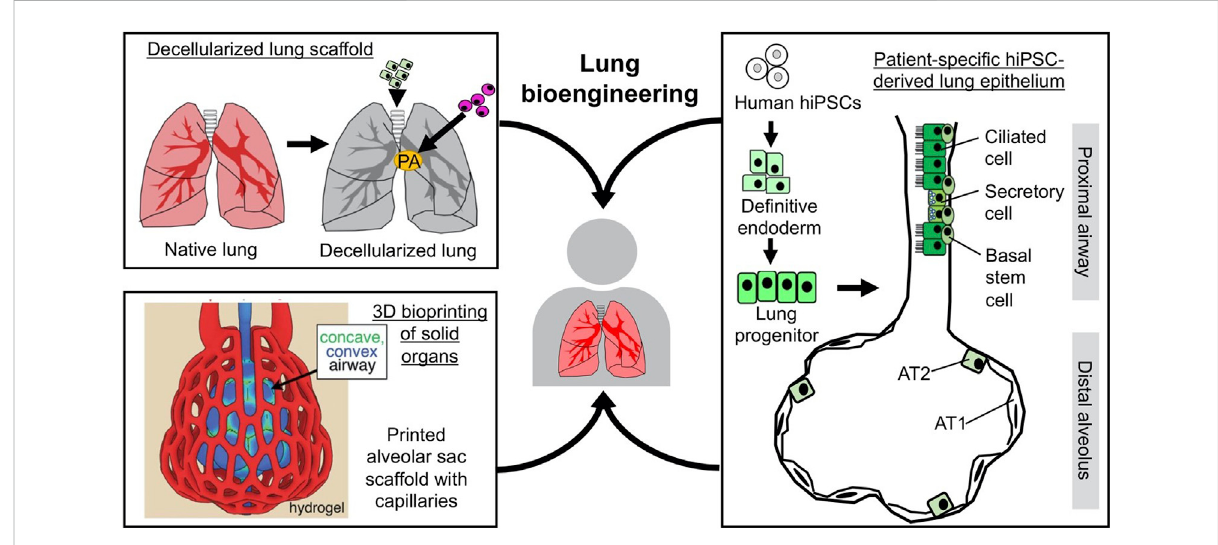
FIGURE 3 Combining regenerative cells and scaffolds for lung bioengineering. The scaffolds can be derived from whole-lung decellularization and 3D bioprinting (adapted from “ Multivascularnetworks and functional intravascular topologies withinbiocompatible hydrogels ” byGrigoryan etal.,2019, Science, 364 (6439), p 461. Copyright 2020 by The American Association for the Advancement of Science. Reprinted with permission). The cells for reconstituting the lung epithelium can be derived from stepwise differentiation of